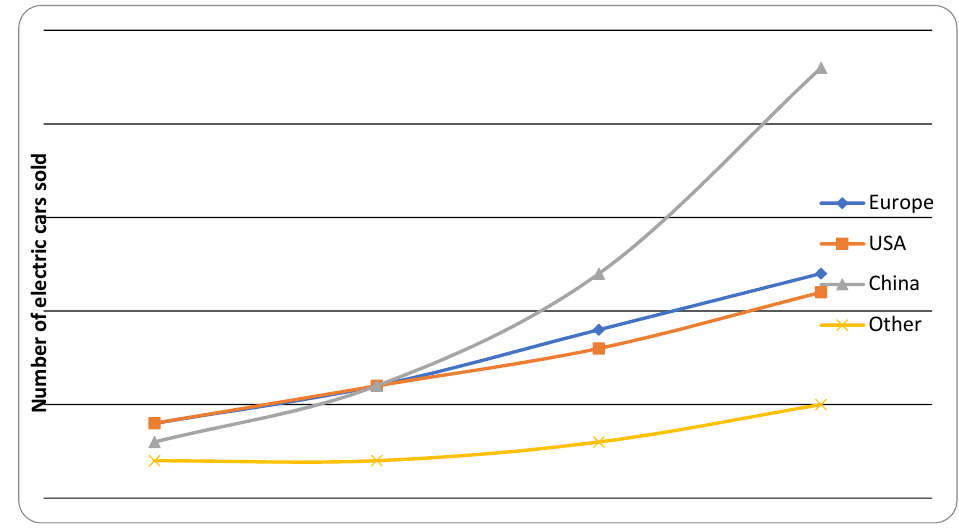
Figure 1. Global electric cars sales according to world’s regions, (source: elaborated by authors based on [4]).